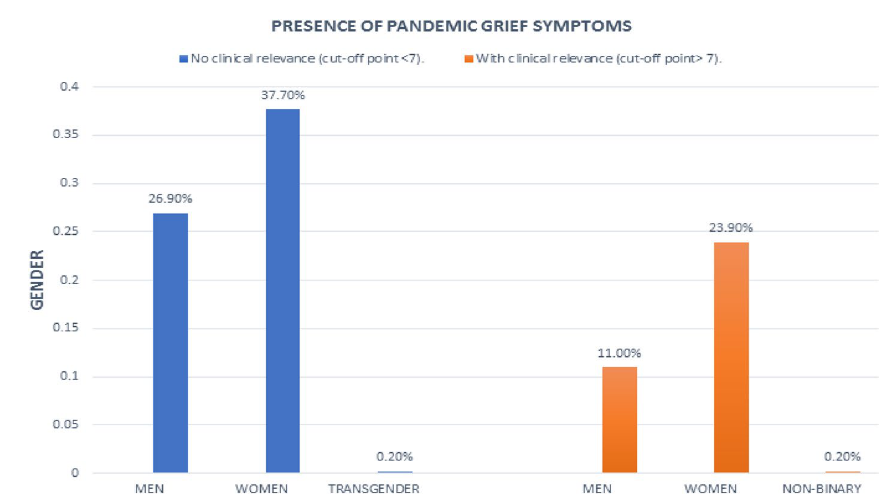
Fig. 1 Presence of pandemic grief symptoms with and without clinical relevance in the